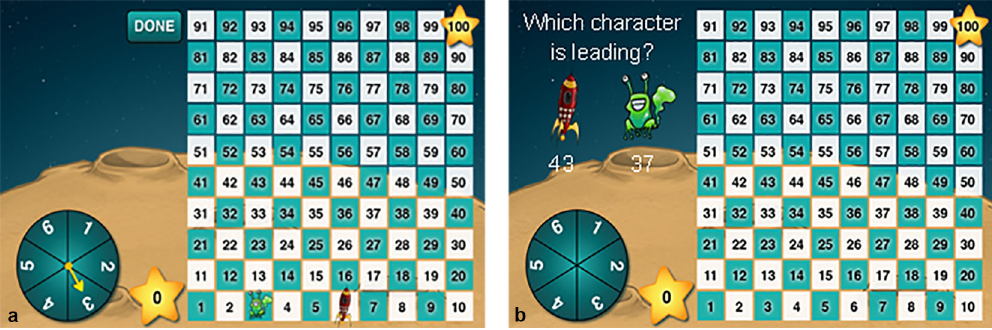
Figure 1. Domain-specific condition: Numerical magnitude knowledge training a) Example of a turn; b) Example of a character magnitude comparison